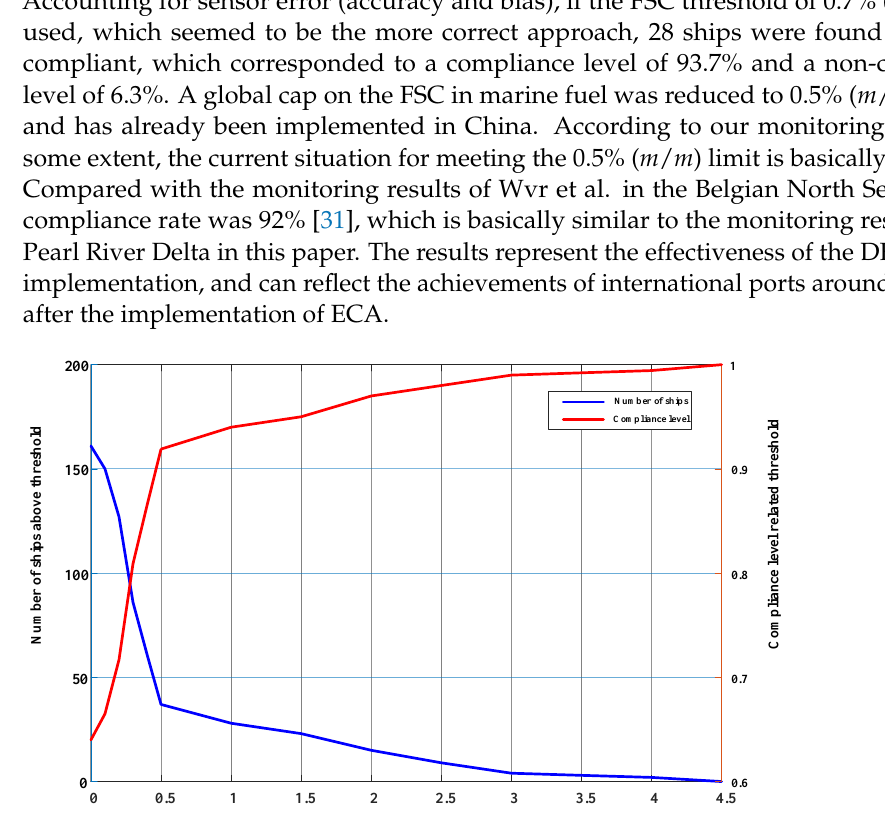
Figure 3. Measurements of FSC distribution.